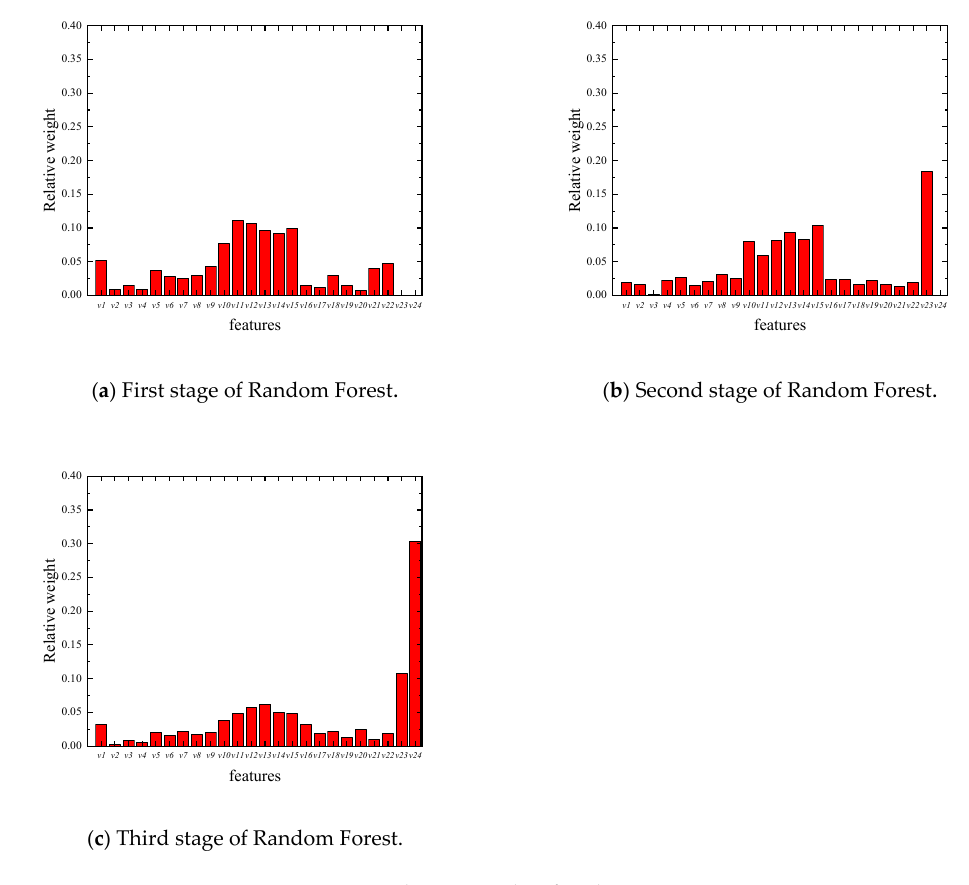
Figure 16. Relative weight of each parameter.